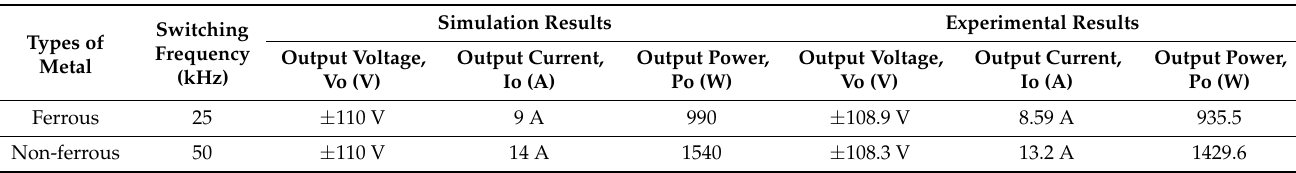
Table 3. Comparison between simulation and experimental results.